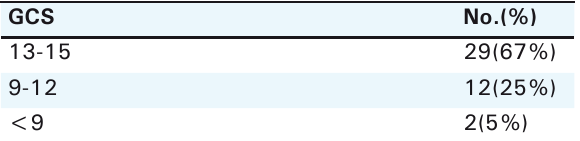
table 5. CT Scan findings